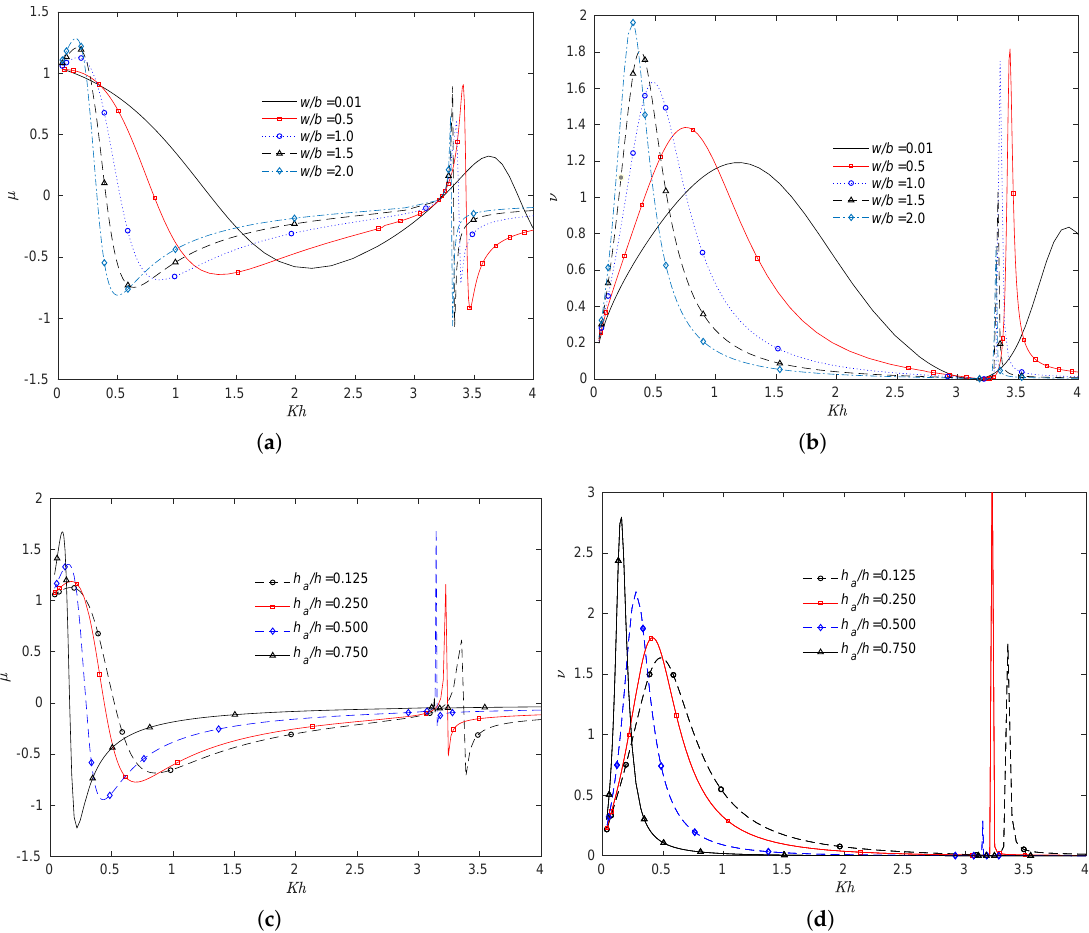
Figure 7. The radiation susceptance and radiation conductance coefficients versus Kh . ( a ) The radiation susceptance coefficient for various thickness ratios w / b with h a / h = 0.125 and b / h = 1.0. ( b ) The radiation conductance coefficient for various thickness ratios w / b with h a / h = 0.125 and b / h = 1.0. ( c ) The radiation susceptance coefficient for different submergance ratios h a / h with w / b = 1.0 and b / h = 1.0. ( d ) The radiation conductance coefficient for different submergance ratios h a / h with w / b = 1.0 and b / h =